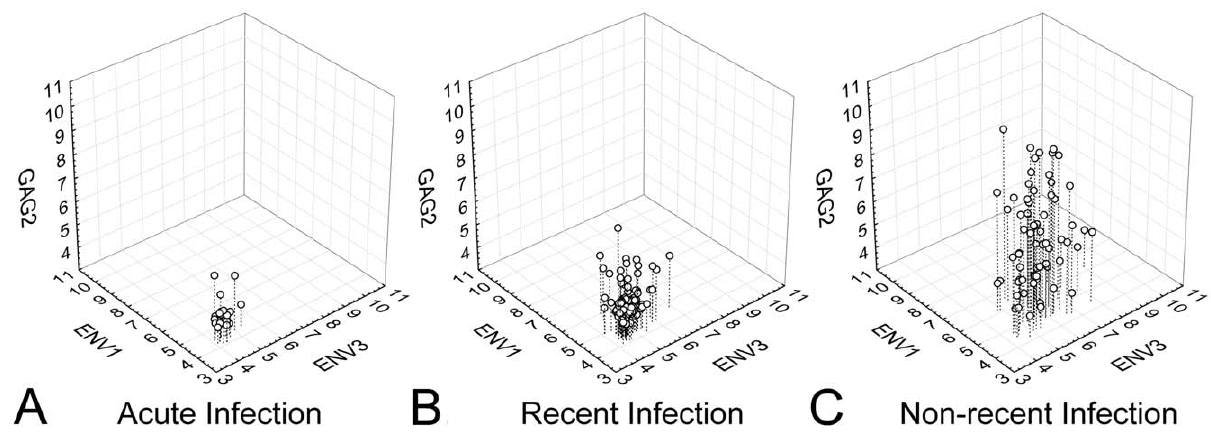
Figure 4. HRM diversity scores for GAG2, ENV1 and ENV3 plotted in 3 dimensions. High HRM scores for these regions were determined to be independently associated with non-recent infection. The use of data from multiple regions in tandem demonstrates that HRM scores are generally compact in acute infection (A) with a slight increase in the distribution of data in recent infection (B), and wide dispersion of the data in non-recent infection